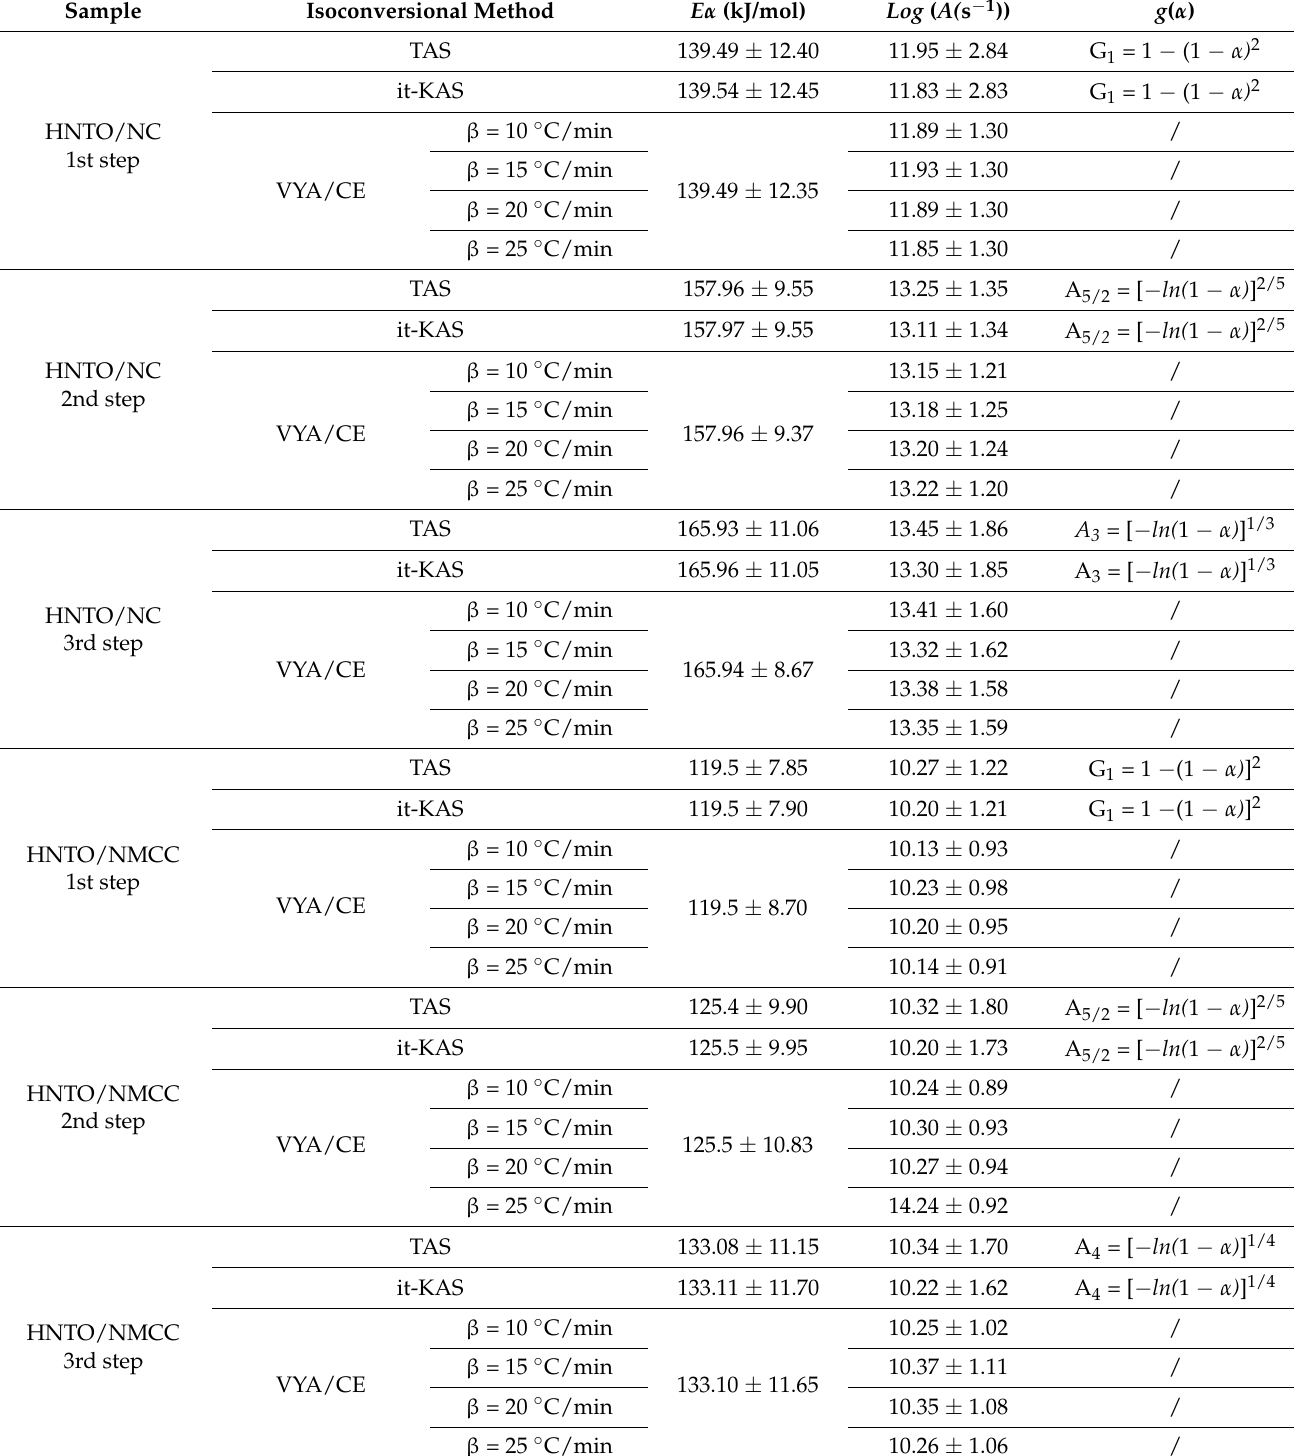
Table 3. Kinetic triplet for the thermal decomposition of the as-prepared